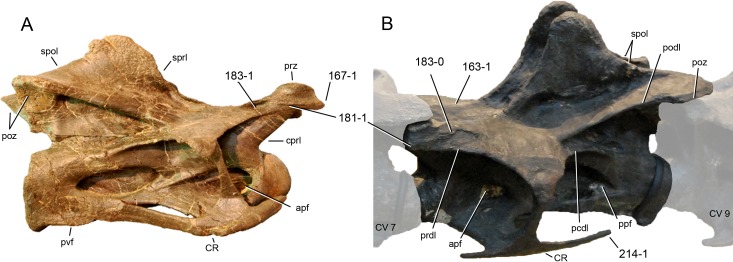
Diplodocine mid-cervical vertebrae.Mid-cervical vertebrae of Kaatedocus siberi SMA 0004 (A; CV 10, modified from Tschopp & Mateus, 2013b) and Diplodocus carnegii CM 84 (B; CV 8) in right lateral (A) and left laterodorsal view (B). Note the reduced spinoprezygapophyseal lamina (B; C163-1), the pre-epipophysis (C181-1), which is anteriorly expanded in K. siberi (A; C167-1), the distinct fossa posterolaterally to the prezygapophysis (A; C183-1), which is absent in CM 84 (B; C183-0), and the short cervical ribs (B; 214-1). Abb.: apf, anterior pneumatic fossa; cprl, centroprezygapophyseal lamina; CR, cervical rib; CV 7, cervical vertebra 7; podl, postzygodiapophyseal lamina; poz, postzygapophysis; ppf, posterior pneumatic fossa; prz, prezygapophysis; pvf, posteroventral flanges; spol, spinopostzygapophyseal lamina; sprl, spinoprezygapophyseal lamina. Not to scale.